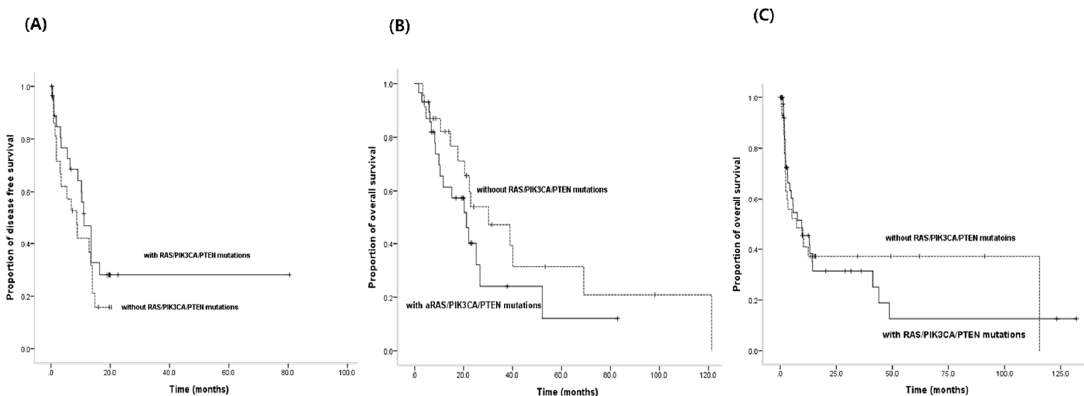
Figure 2. The effect of RAS/PIK3CA/PTEN mutations on clinical outcomes in patients with EGFR TKI treatment. ( A ) Time to progression for EGFR TKIs according to RAS/PIK3CA/PTEN mutations ( p = 0.246): there was no difference between two groups. ( B ) Overall survival in patients with EGFR TKIs according to RAS/PIK3CA/PTEN mutations ( p = 0.182): patients with RAS/PIK3CA/PTEN showed shorter OS values. ( C ) Overall survival in patients without EGFR TKIs according to RAS/PIK3CA/PTEN mutations ( p = 0.836): there was no difference between two groups. 3.5. PFS for EGFR-TKIs and OS According to both Activating EGFR Mutation Status and Status of